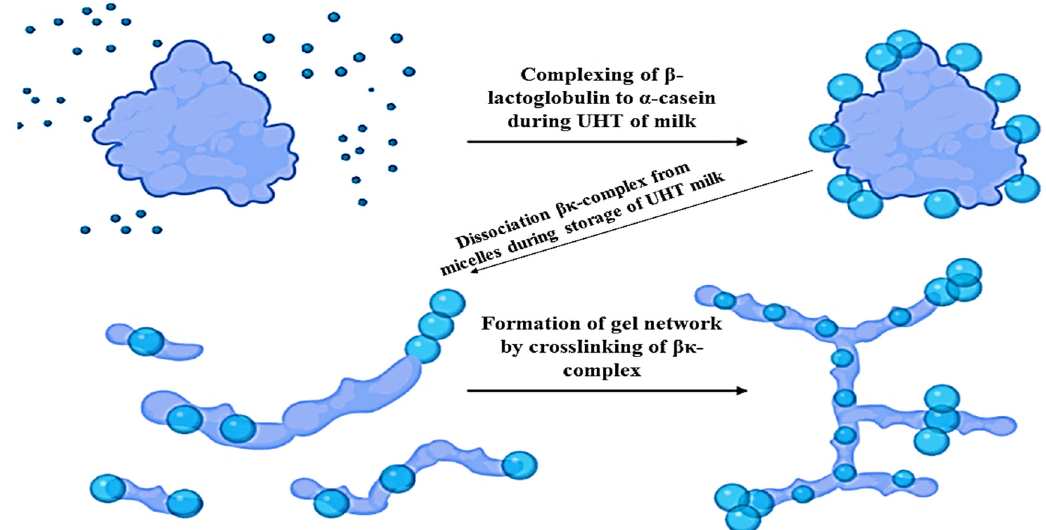
Figure 2. Effect of UHT process on structural chemistry of casein proteins [36]. According to the proposed mechanism, UHT milk gelation is due to specific k-casein proteolysis. Dissociation of β - k-casein complex occurs, which leads to gel-like structure formation by crosslinking of β - k-casein complex.